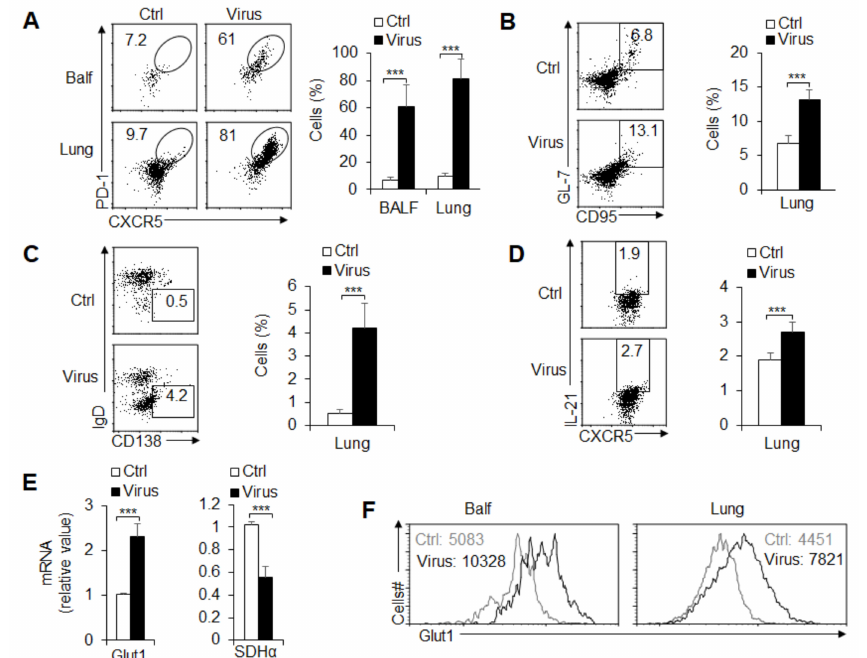
Figure 3. T FH cell di ff erentiation is associated with glycolysis and OXPHOS upon influenza virus PR8 infection. Mice infected with influenza H1N1 virus PR8-infected mice at 8 days and BALF and lungs were isolated for analysis. ( A ) Flow cytometry of T FH cells in BALF and lungs. The right panel shows the frequency of T FH cells. ( B , C ) Flow cytometry of GC B cells (B) and plasma cells (C) in lungs. The right panel shows the frequency of GC B cells and plasma cells. ( D ) The percent of IL-21 + T FH cells in the lungs. The right panel shows the statistical results. ( E ) Glut1 and Sdh α mRNA expression was analyzed by real-time PCR in CXCR5 + PD1 + CD4 + T FH cells sorted from BALF. ( F ) Flow cytometry analysis of the MFI of Glut1 expression in T FH cells in BALF and lungs. Data are representative of three individual experiments (n = 3–6 mice per group). *** p < 0.001, compared with the indicated